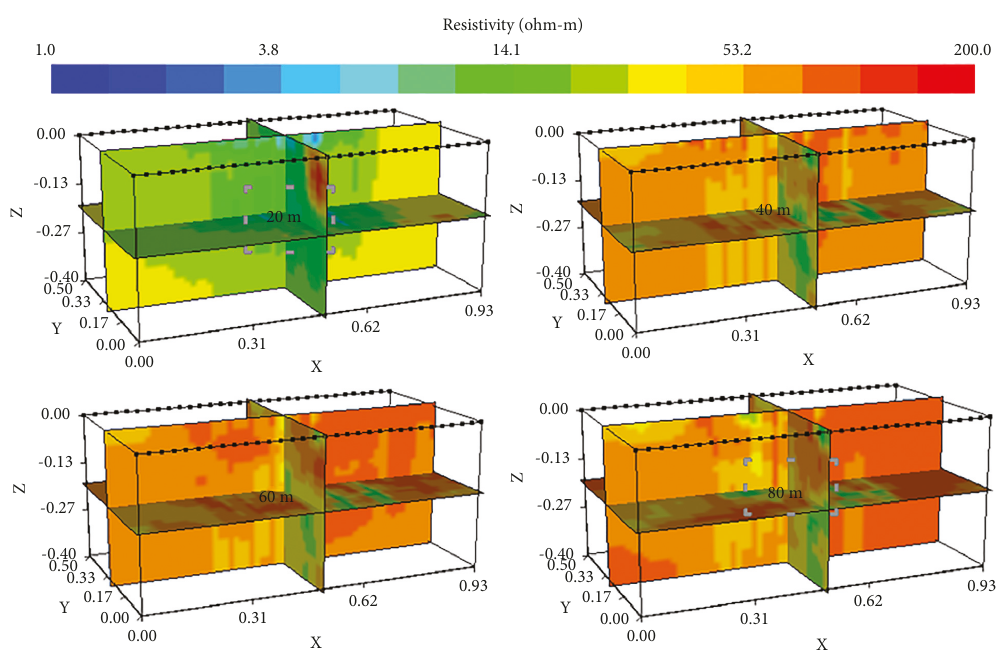
Resistivity (ohm-m)